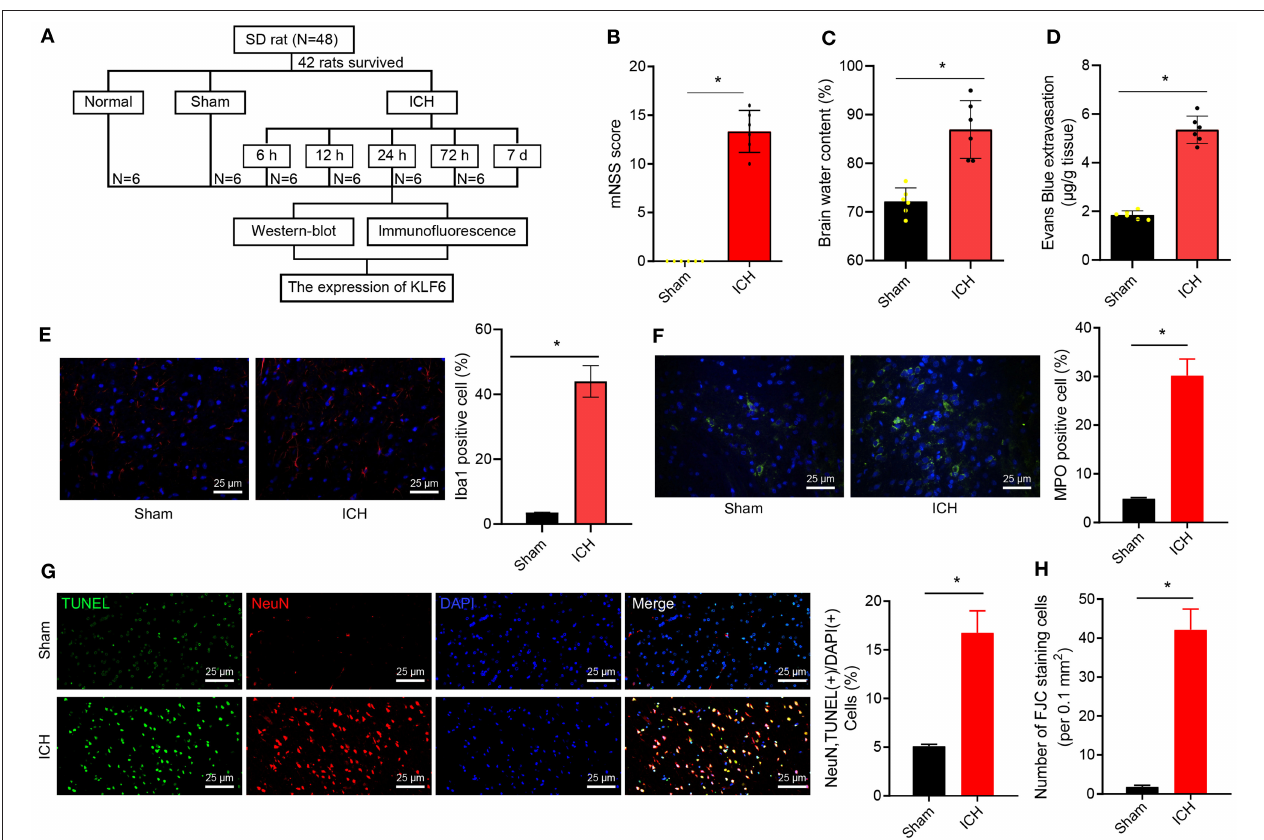
FIGURE 2 | Successful establishment of ICH rat models. (A) ICH model establishment. (B) mNSS scoring of rats 72h after ICH modeling. The scoring includes severe injury (10–14 points), moderate injury (5–9 points), and mild injury (1–4 points). (C) Water content in brain tissues of rats 72h after ICH modeling. (D) The penetration of Evans blue in rat brain tissues 72h after ICH modeling. (E) The activation of microglia 72h after ICH modeling detected by immunofluorescence staining (Iba1 + cells were quantified). (F) The activation of neutrophils was detected by immunofluorescence staining (MPO + cells were quantified). (G) The apoptosis of hippocampal neurons 72h after ICH modeling detected by TUNEL staining (NeuN + TUNEL + cells were quantified). (H) The quantitative analysis of degeneration of hippocampal neurons in the cerebral cortex 72h after ICH modeling detected by FJC staining. * p < 0.05 compared with sham-operated rats. n = 6 rats/group. The measurement data were expressed as mean ± standard deviation. Comparisons between two groups were analyzed using unpaired t -test, and comparisons among multiple groups were tested by one-way ANOVA followed by Dunnett post-hoc